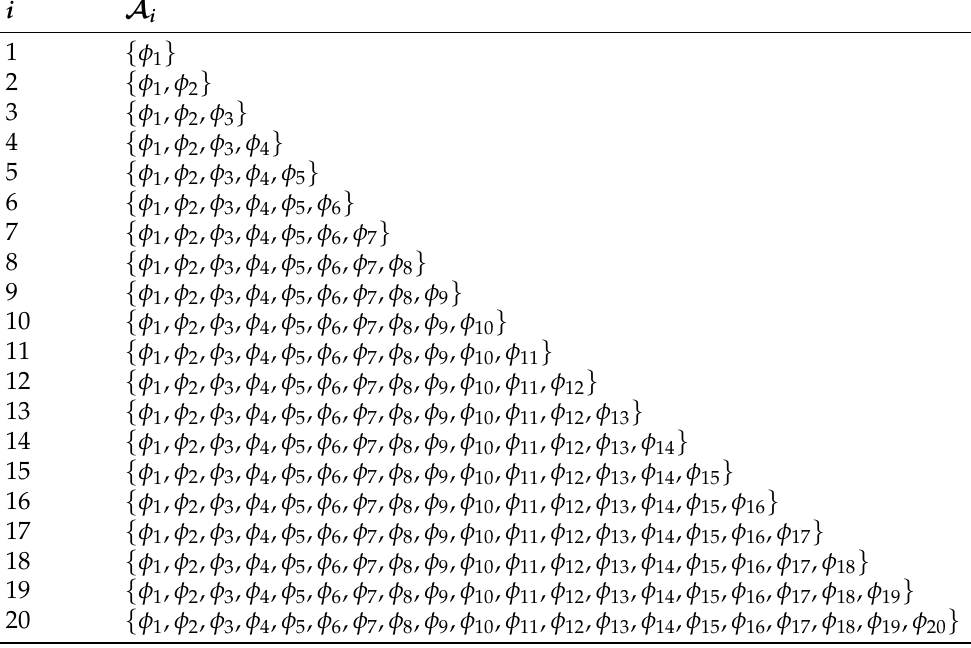
Table 1. The variation in A i